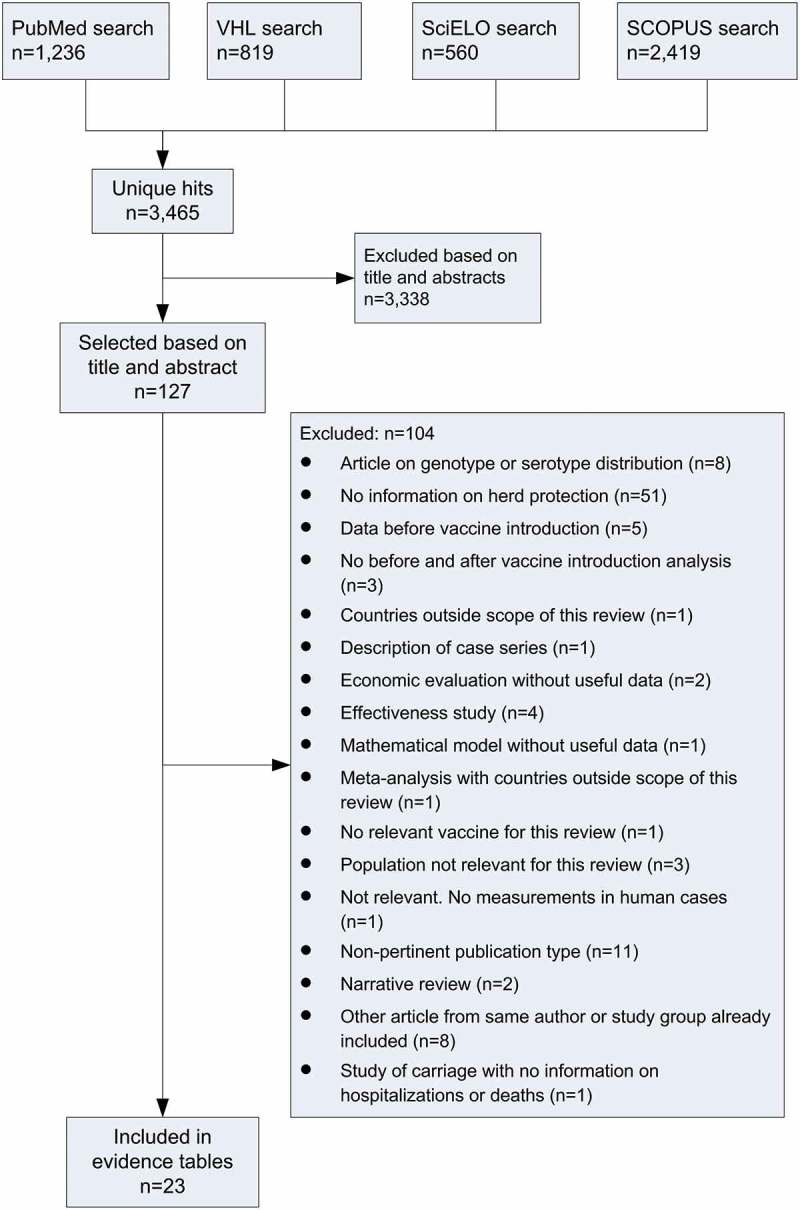
Search results and study selection.